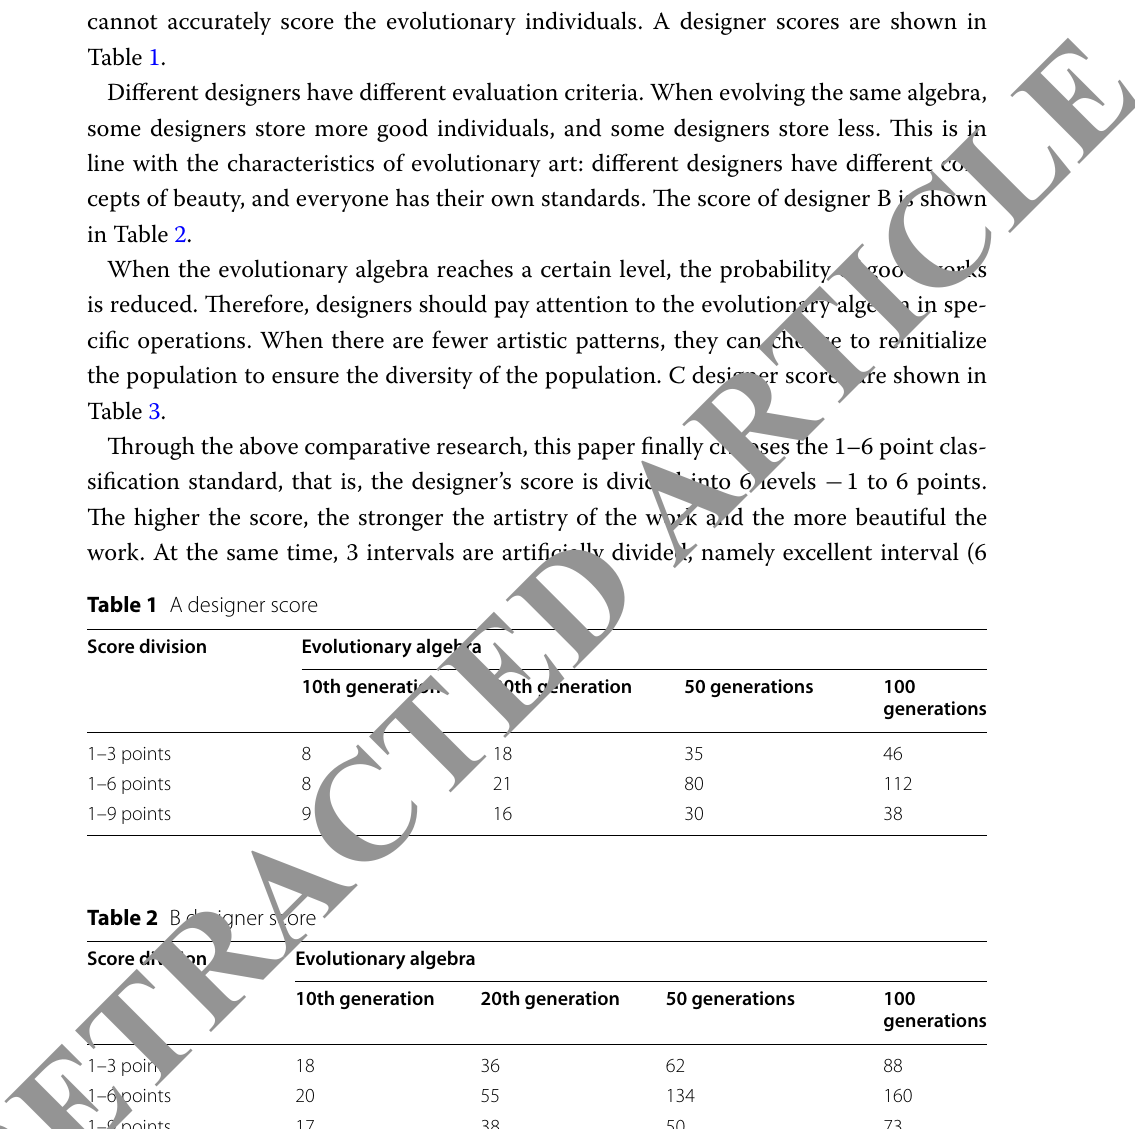
Score division Evolutionary algebra